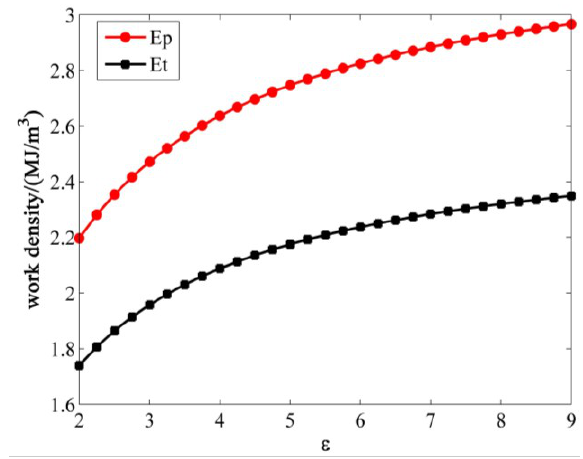
Figure 5. The variation of work density with water-air volume